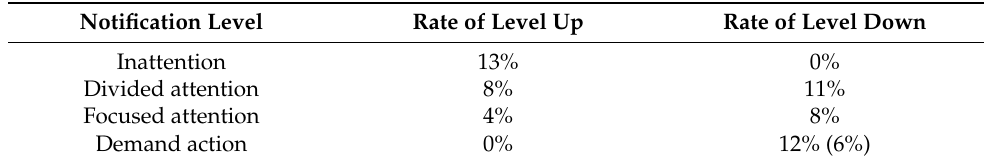
Table 7. Rate of unexpected